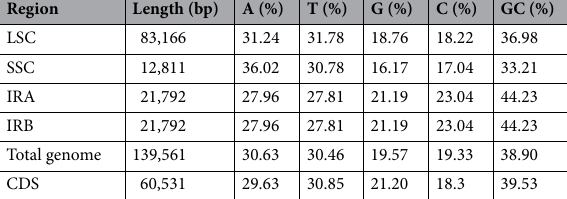
Table 2. Base composition in the C. hirtinoda choloroplast genome.